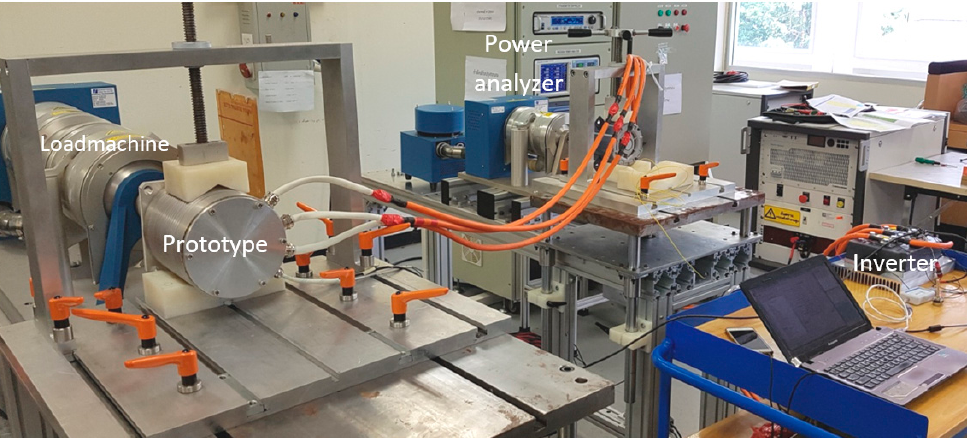
Figure 11. Experimental measurement on test-bench.